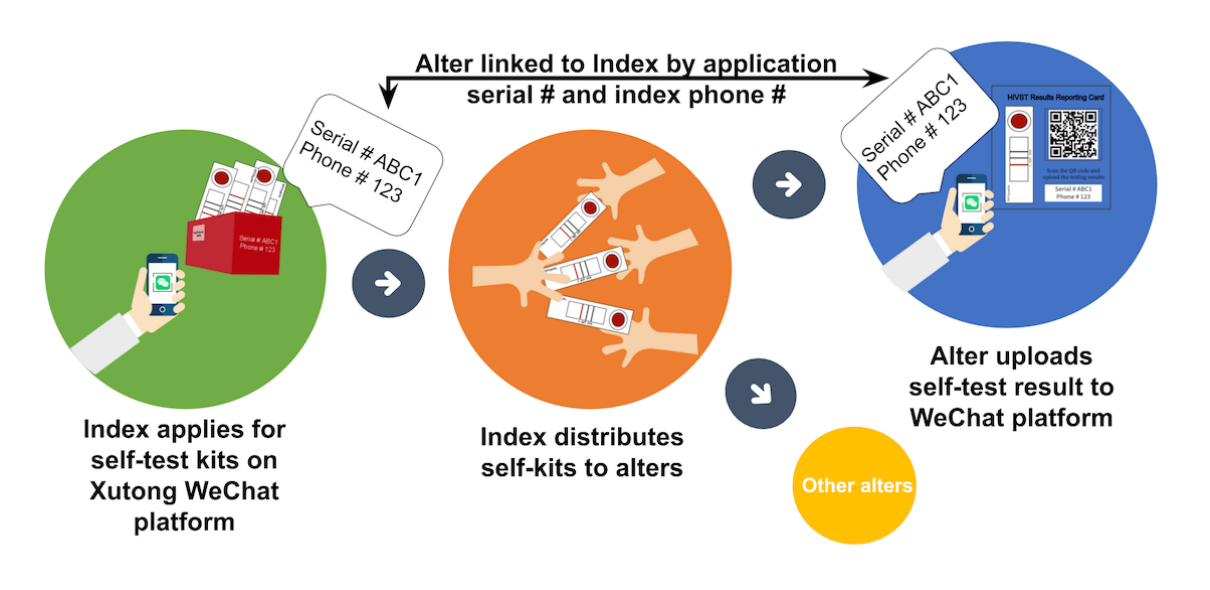
Figure 1. HIV/syphilis self-tests application, distribution, and linkage of alters to indexes.